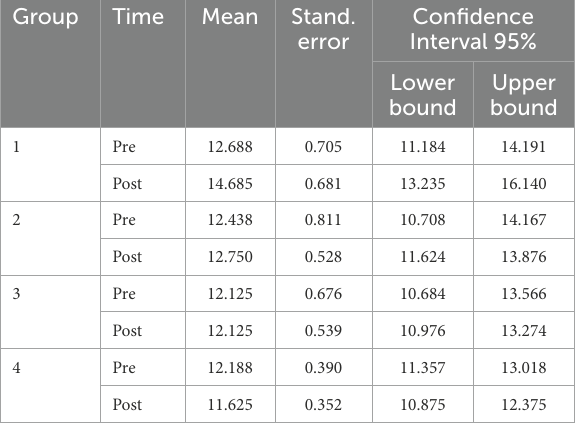
TABLE 11 Fear of severe pain means by comparing groups and time. Group Time Mean Stand. error